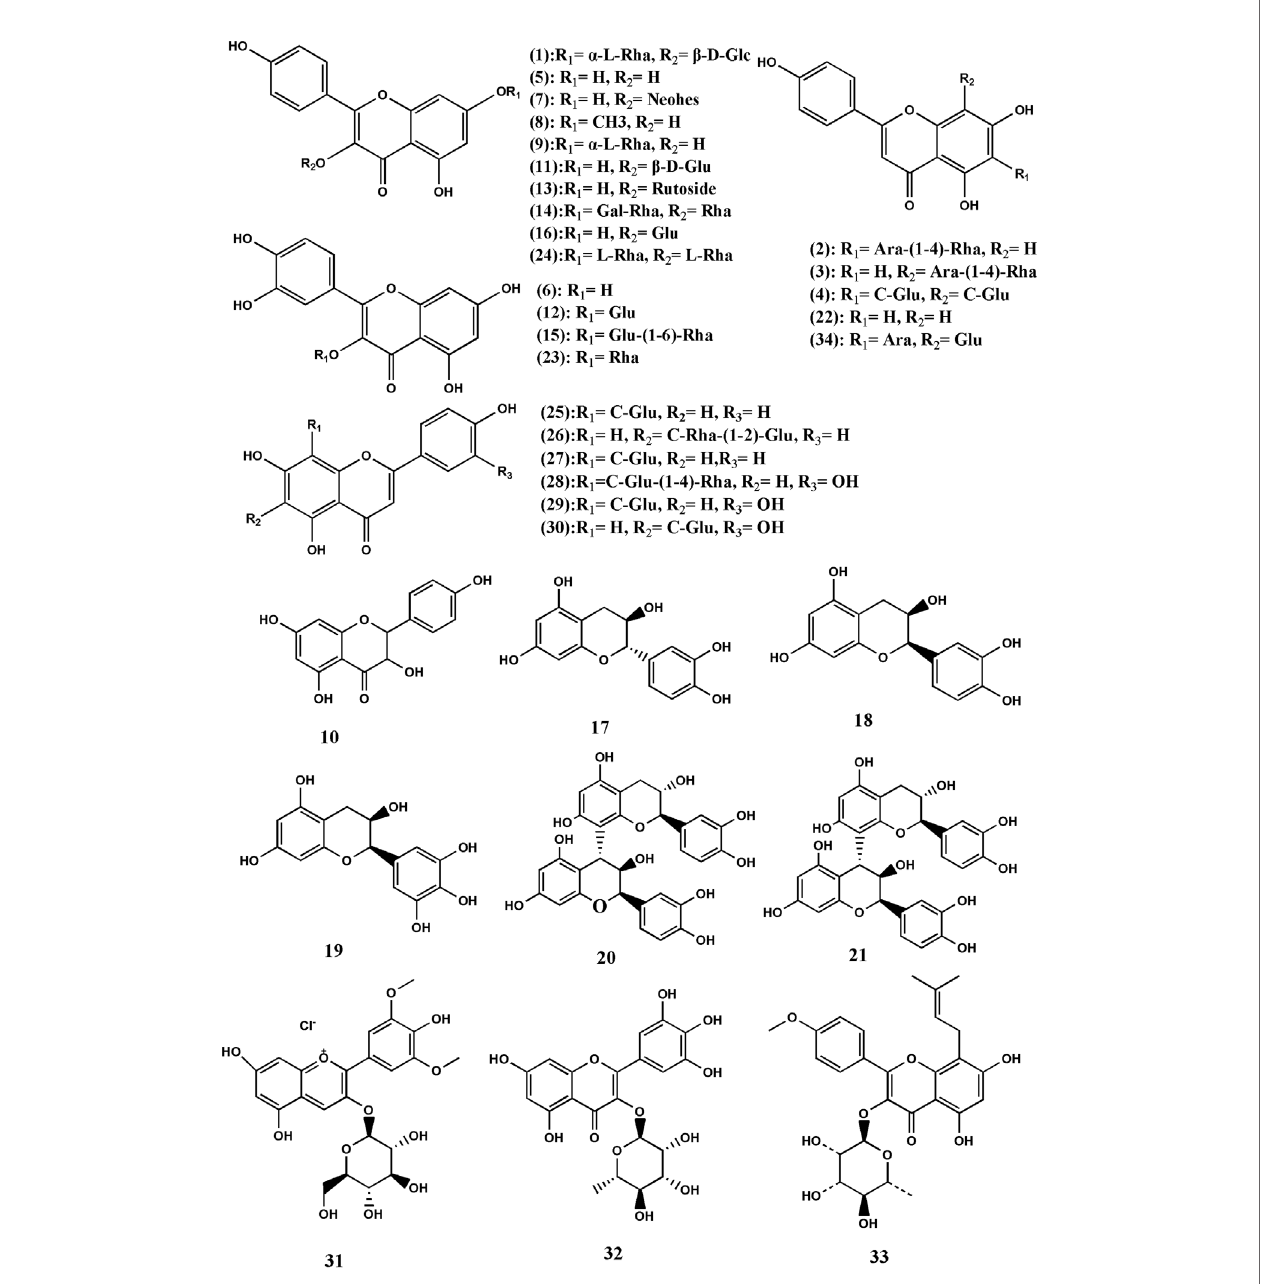
FIGURE 2 | Structures of the fl avonoids from Tetrastigma hemsleyanum Diels &